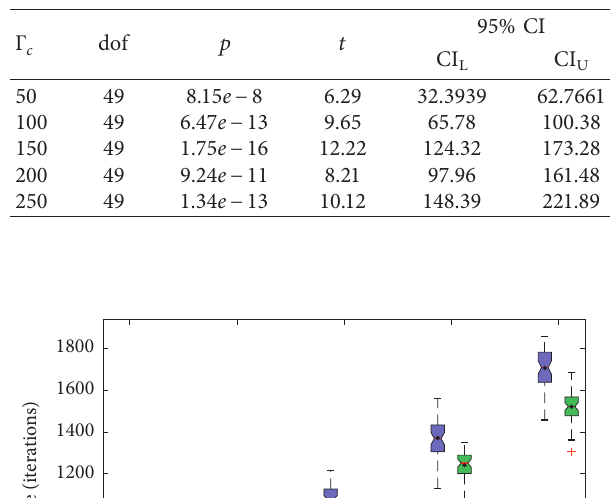
Table 1: Paired T -test.